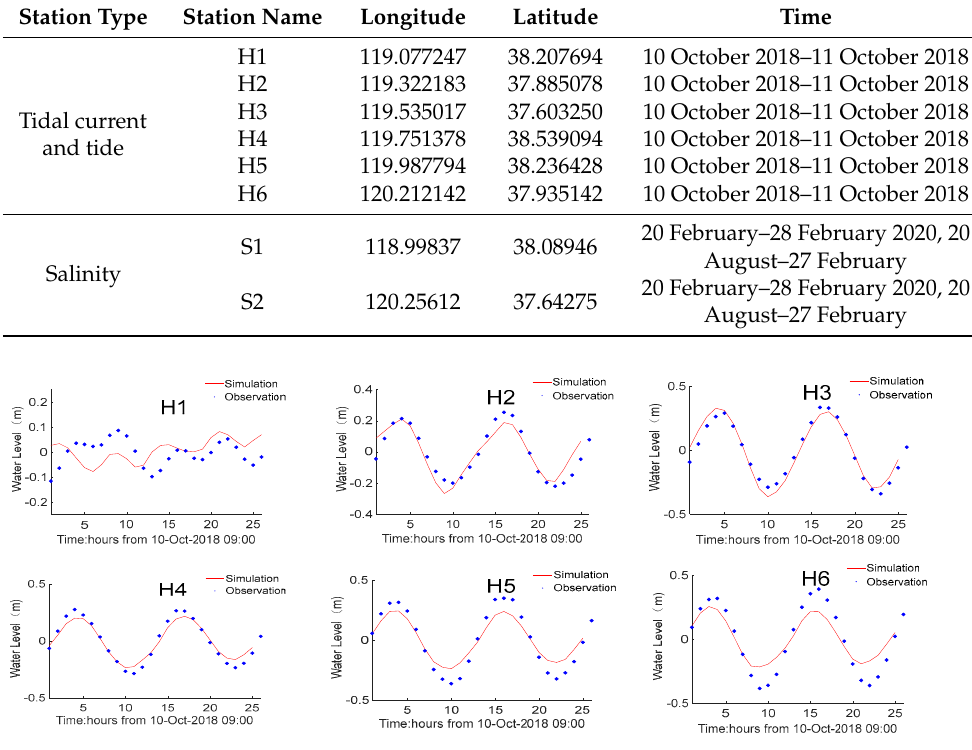
Figure 6. Veri fi cation of tidal level. Figure 6. Verification of tidal